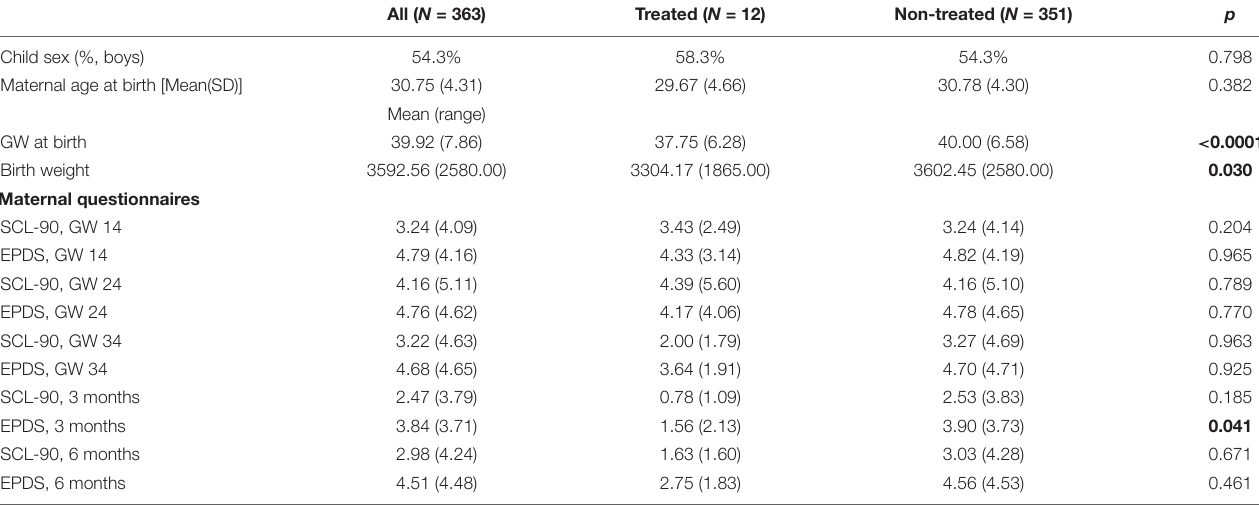
TABLE 1 | Characteristics of the study sample. All ( N = 363) Treated ( N = 12) Non-treated ( N =